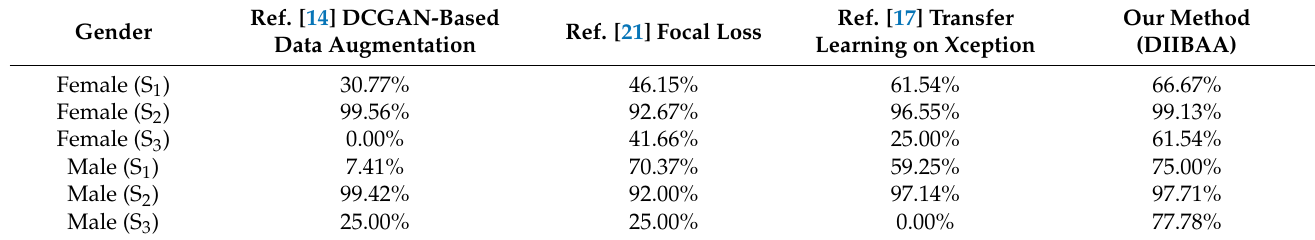
Table 9. Accuracy on three common methods for data imbalance alleviation.